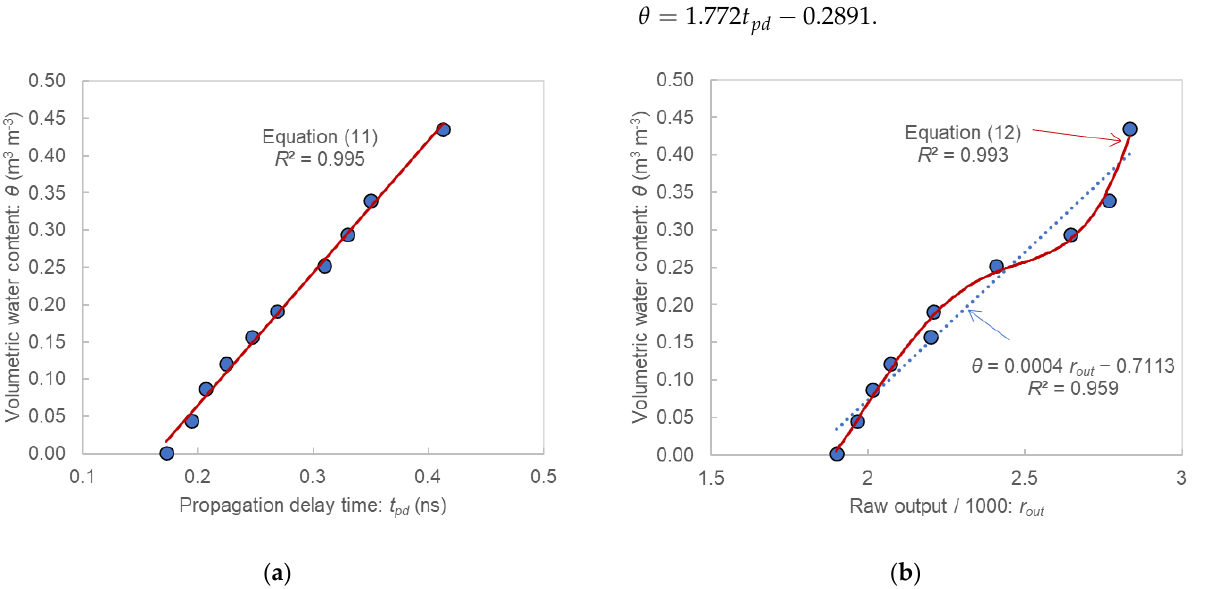
Figure 5. Relationships between the output and the volumetric water content of the samples: ( a ) for the SFDT sensor; ( b ) for the TEROS12 sensor.